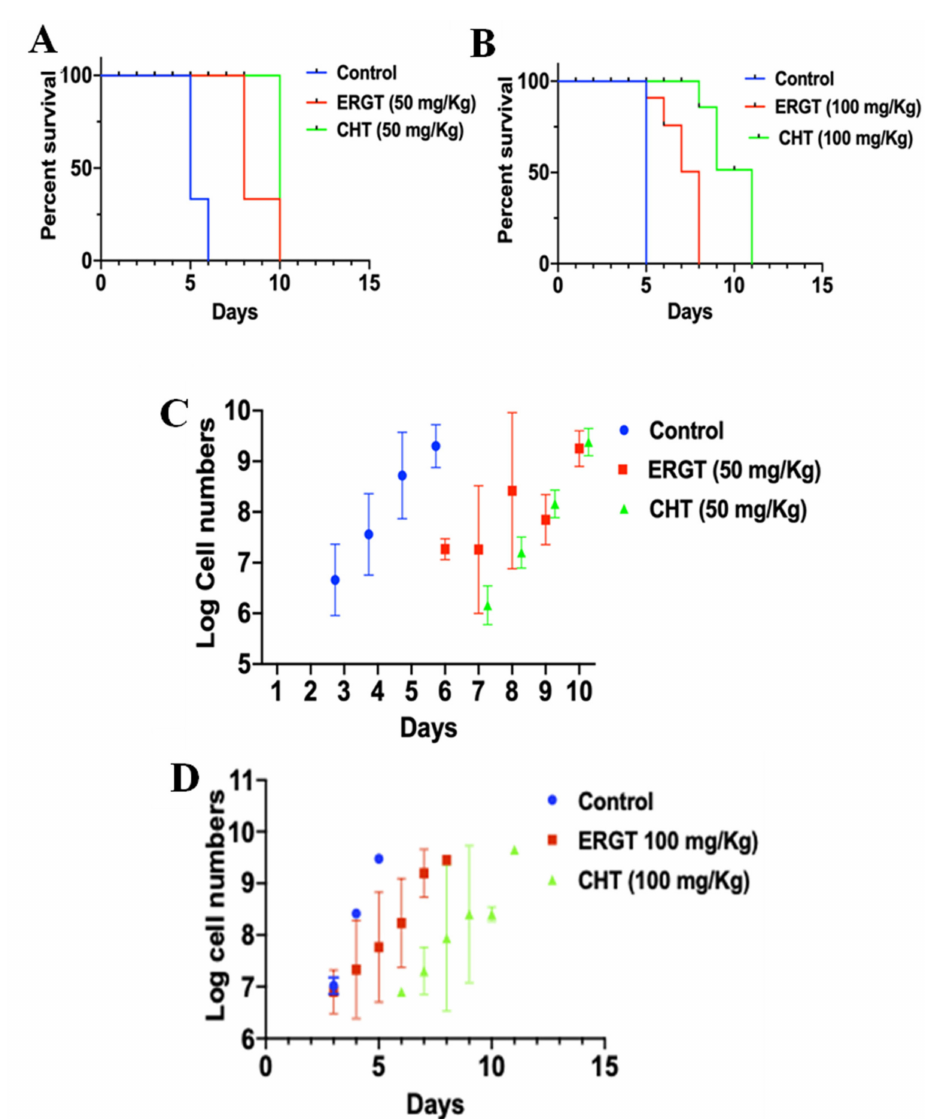
Figure 6. Protective role of CHT/ERGT on animal infection with T. brucei . Six groups of Balb/C mice (5 mice in each group) were injected intraperitoneally with T. brucei bloodstream form parasite (1 × 10 4 cells/mouse). Two groups were treated with ERGT (50 mg/kg) or CHT (50 mg/kg) via intraperitoneal injection once per day post-infection ( A ). Another two groups of mice were treated with ERGT 100 mg/kg) or CHT (100 mg/kg) ( B ) via the same route once per day post-infection. Controls for these groups were injected with appropriate amount of buffer used to prepare the antimetabolites. The blood parasitemia levels were monitored each day post-infection by counting the number of T. brucei in blood collected from the tail vein. Survival curves for the control (infected but not treated with any drug) and infected mice treated with ERGT were plotted using Graphpad Prism. To reduce the pain and distress mice were sacrificed when the parasitemia levels reached >5 × 10 8 cells/mL of blood and death is considered one day after euthanasia. ( C , D ) Log of parasite numbers in the blood of the infected mice are plotted against days post infection. Standard deviations were calculated from 5 counts from each mouse on each day. Parasite numbers on day 1 and 2 post-infection were below the detection